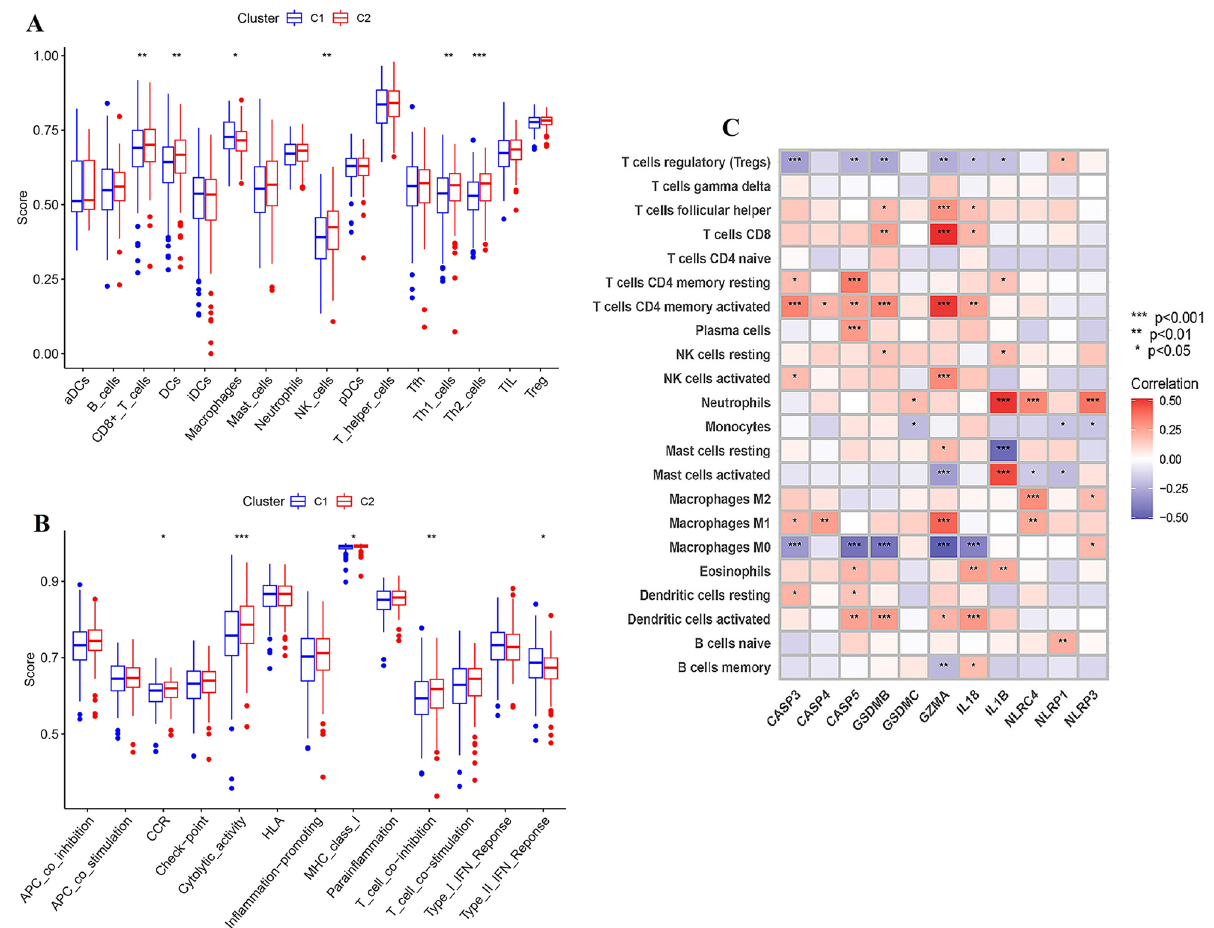
Figure 4. Immune analysis for clusters. ( A ) and ( B ) The difference in immune cell infiltration and immune functions between clusters; ( C ) the correlation between pyroptosis-related genes and infiltration of immune